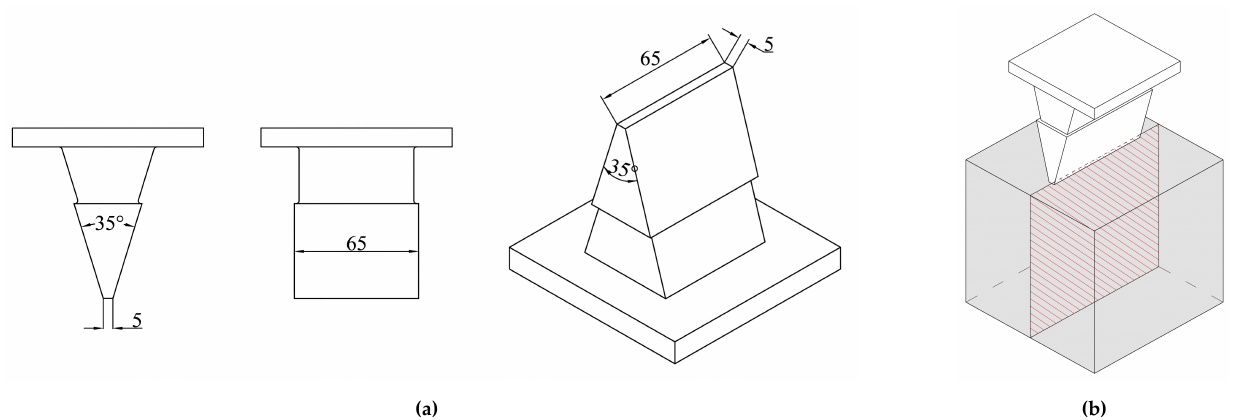
Figure 7. Wedge test method: ( a ) the wedge and ( b ) wedge position while testing cutting force. This test method suggests that the rock sample is installed into a suitable hydraulic press, used to apply the vertical force to the wedge. The vertical force constantly increases until the sample splits. During the tests and determining the value of the force which led to the sample splitting, the size of the wedge penetration into the specimen is recorded